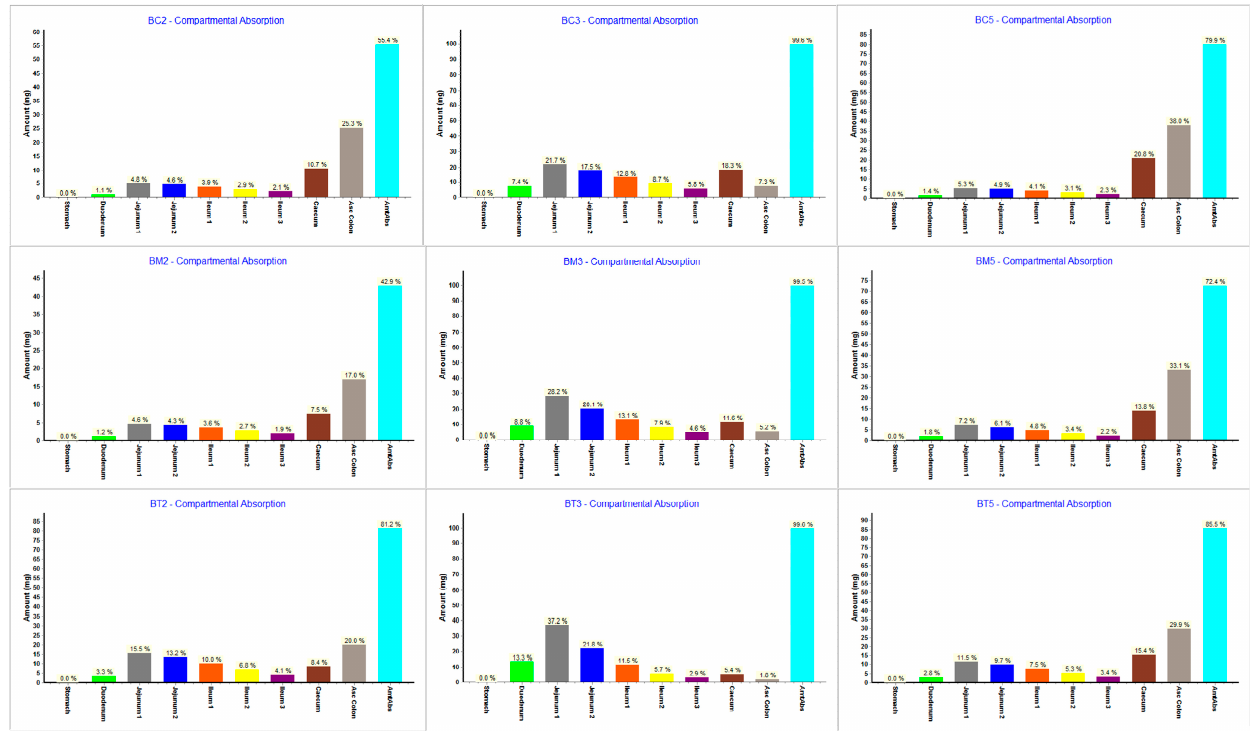
Figure 10. Gastrointestinal simulation of regional absorption distribution for the tested